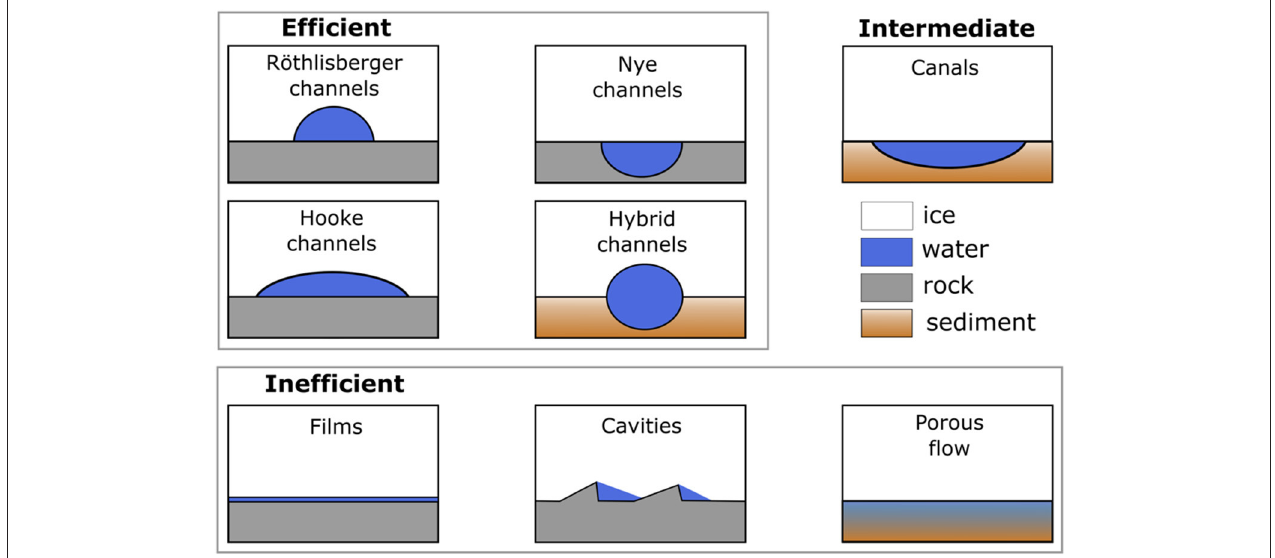
FIGURE 4 | Conceptualised efficient, inefficient, and example intermediary subglacial drainage forms, as described in text. Channels and cavities are depicted as filled with water, but they may not be if they are not in steady-state. Ice flow is into the page, except for inefficient cavities, where ice flow is